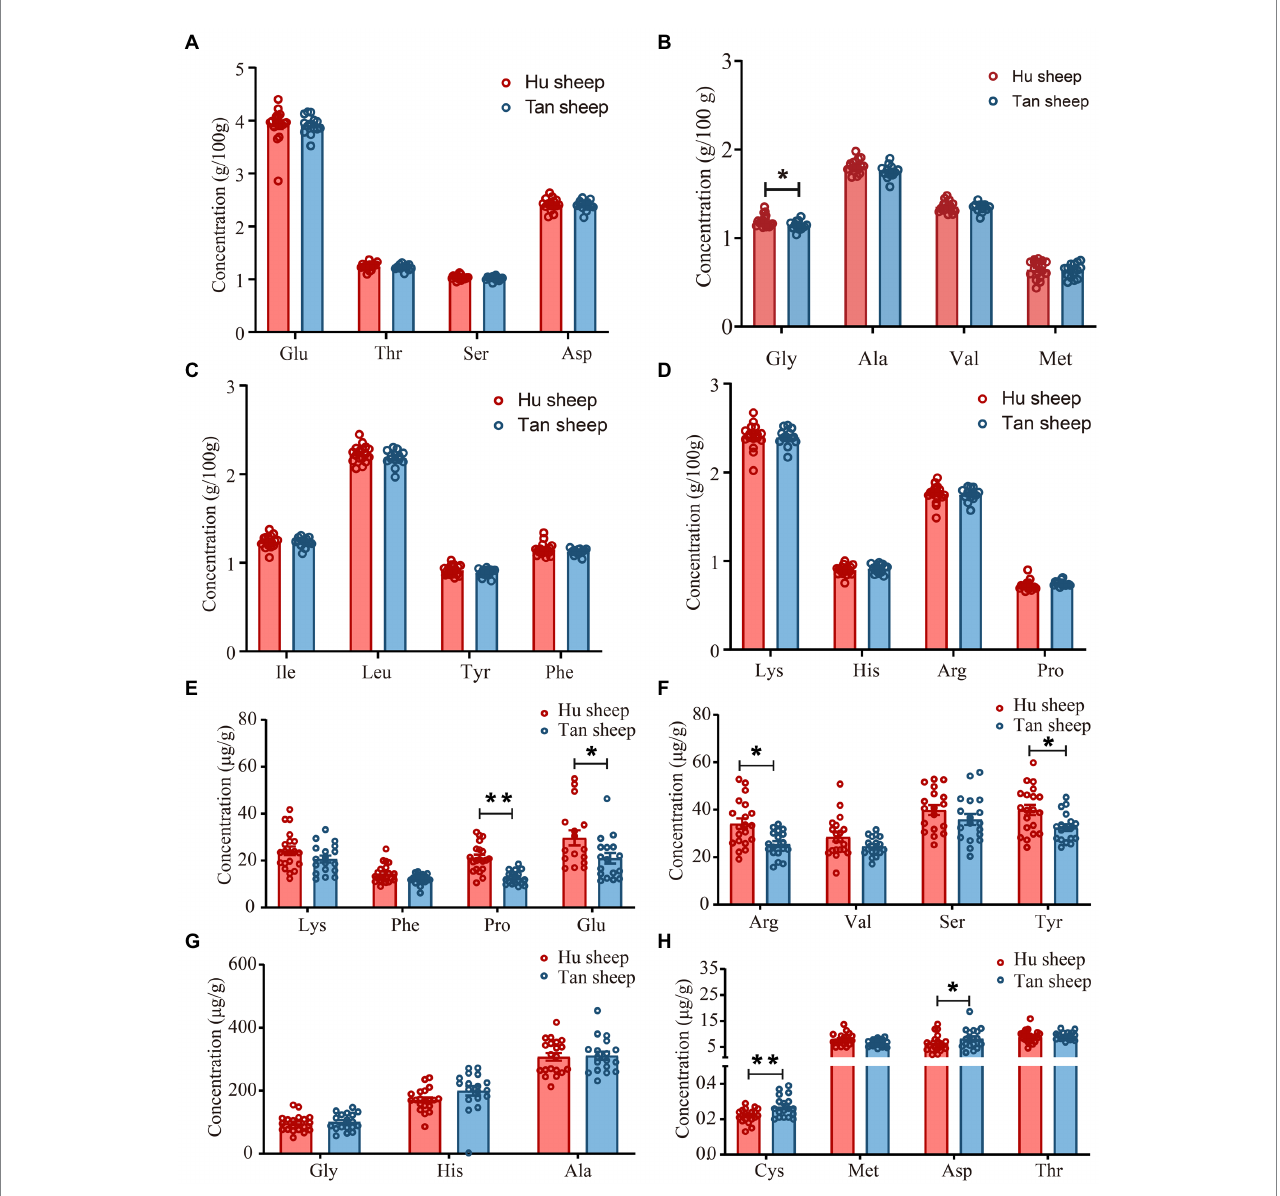
FIGURE 1 (A–D) Total and (E–H) free amino acid profiles of psoas major muscles from Hu and Tan sheep ( n = 20). Gly, glycine; Ala, L-alanine; Val, L-valine; Leu, L-leucine; Ile, isoleucine; Pro, L-proline; Phe, L-phenylalanine; Tyr, L-tyrosine; Ser, L-serine; Thr, L-threonine; Met, L-methionine; Asp., L-aspartic acid; Glu, L-glutamic acid; Lys, L-lysine; Arg, L-arginine; His, L-histidine; Cys, L-cystine. * p < 0.05, ** p <